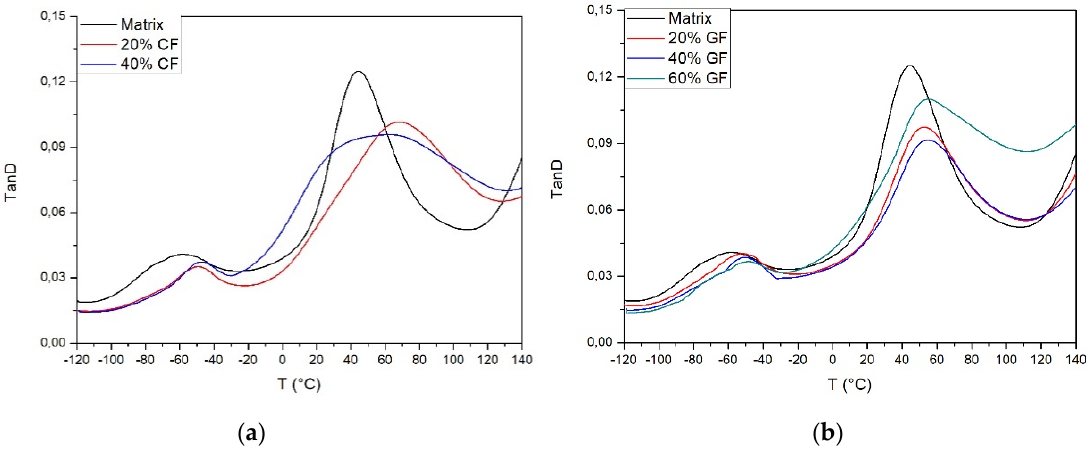
Figure 3. Loss factor (Tan δ ) values for ( a ) carbon fiber composites, ( b ) glass fiber composites.